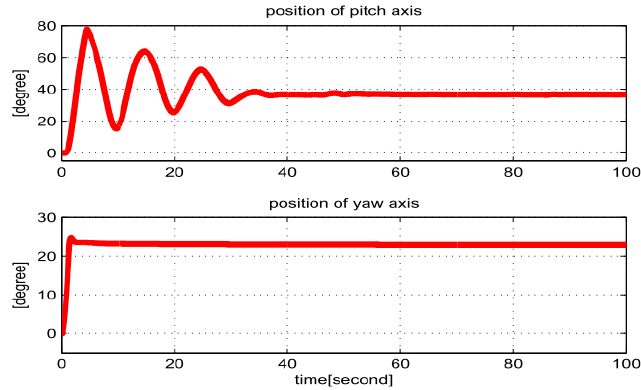
Fig. 5. Angular pitch (top) and yaw (bottom) positions for proportional controllers with gains 10 and 3000 for the main and tail motors, respectively.